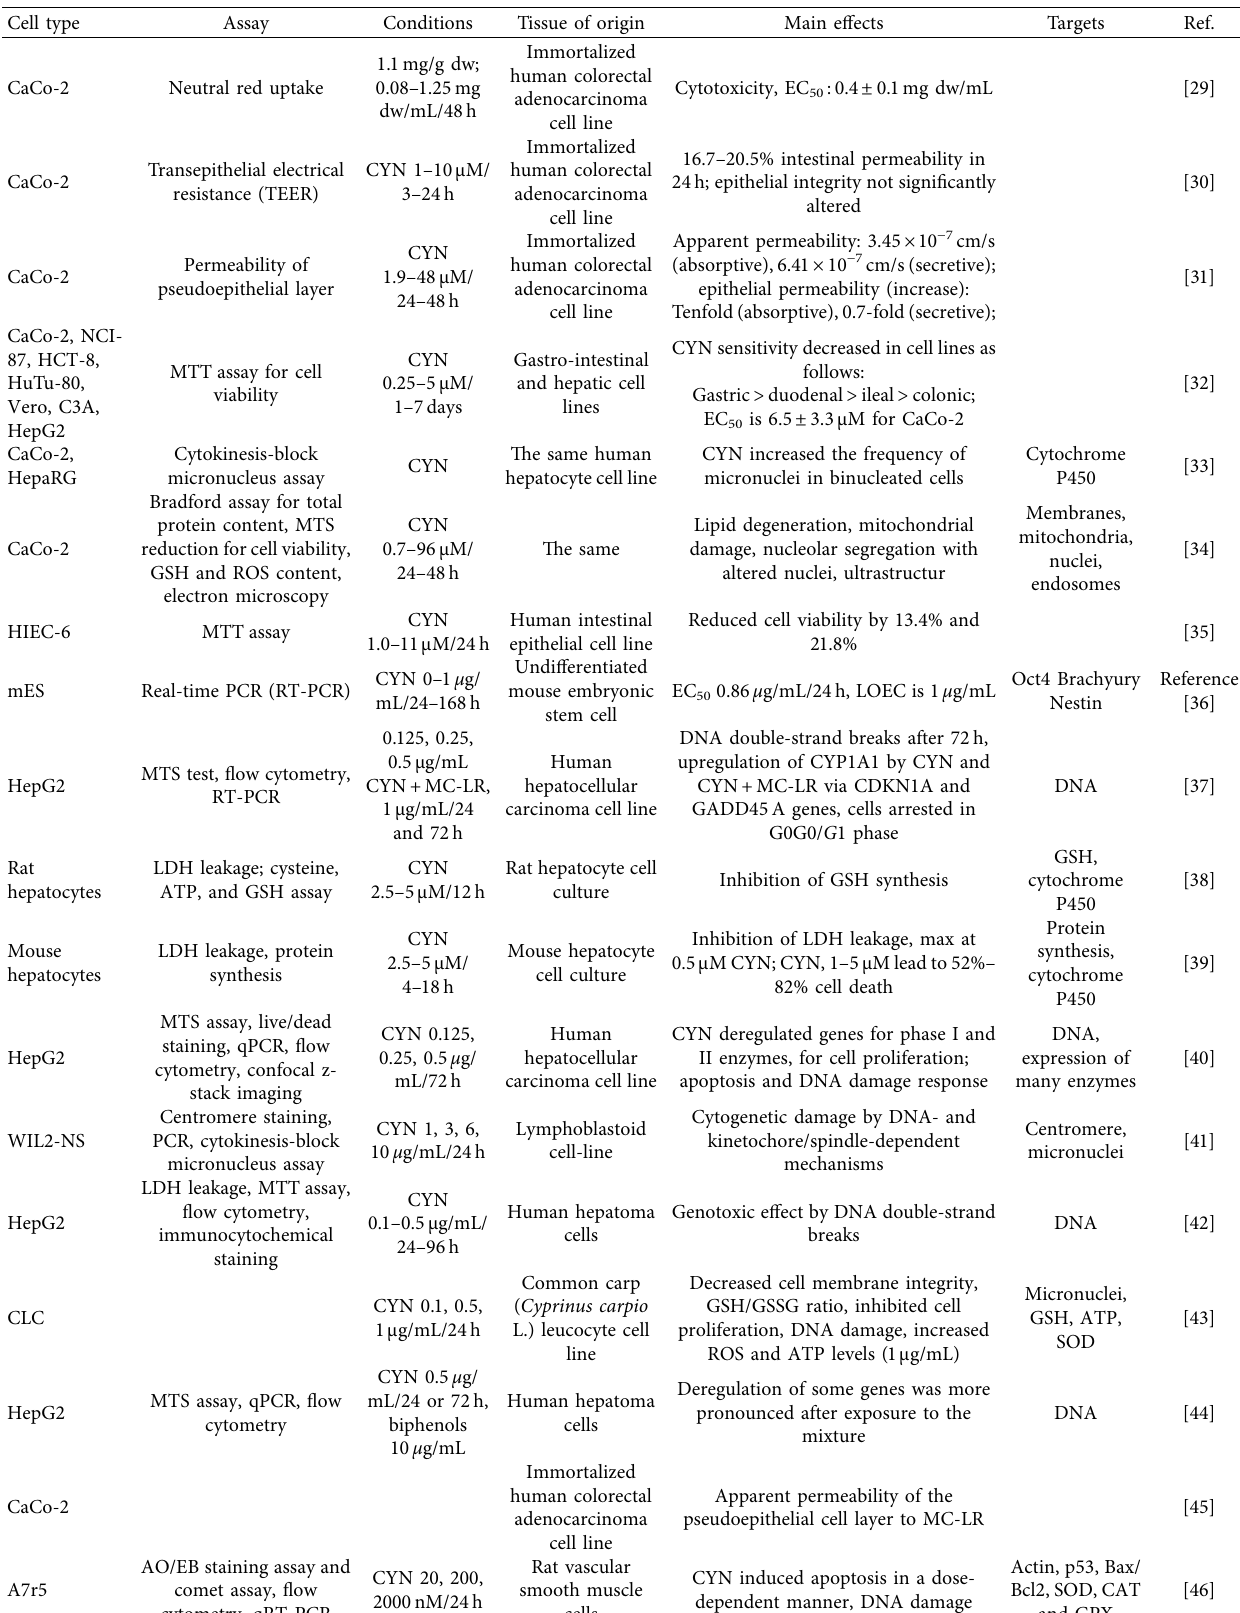
Table 4: Cytotoxicity of